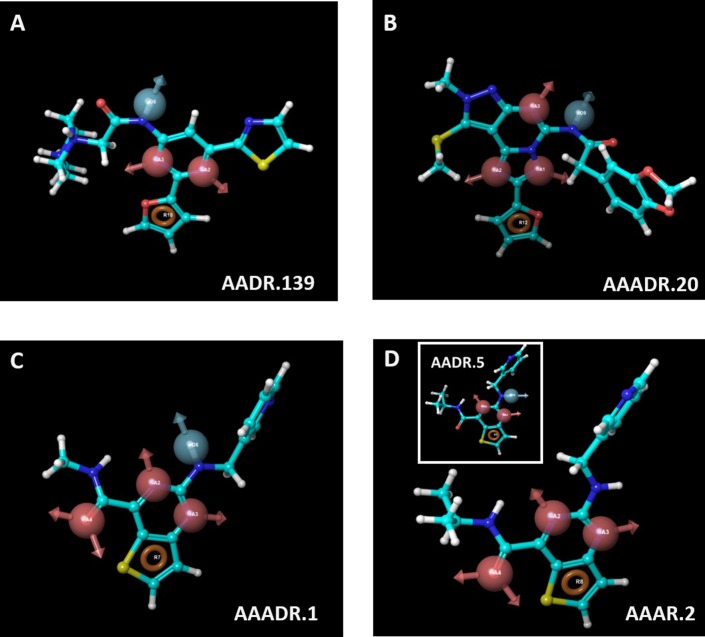
The reference ligands used for model AADR.139 (A), AAADR.20 (B), AAADR.1 (C), and AAAR.2 (D). The insert of Fig 4D shows that model AADR.5 shared the same reference compound (N-isopropyl-2-((pyridin-3-ylmethyl)amino)thieno[3,2-d]pyrimidine-4-carboxamide) as model AAAR. 2. Hence, N-isopropyl-2-((pyridin-3-ylmethyl)amino)thieno[3,2-d]pyrimidine-4-carboxamide contained all five pharmacophore sites in model AAADR.1, as described in details in Results. Hydrogen bond acceptor was shown in magenta vector, hydrogen donor was shown in light blue vector, and aromatic residues were shown in brown ring.